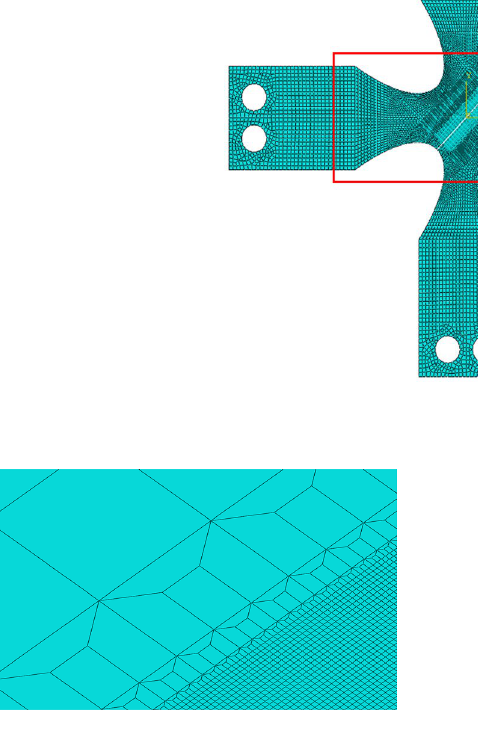
Fig. 15 Finite element model for cruciform specimen with an inclined crack and the refined mesh